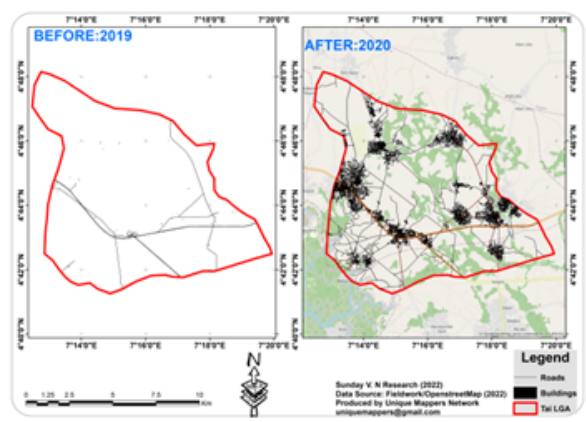
Figure 14: Before and After six months OpenStreetMap Contri- bution TImeline by RVM for Tai